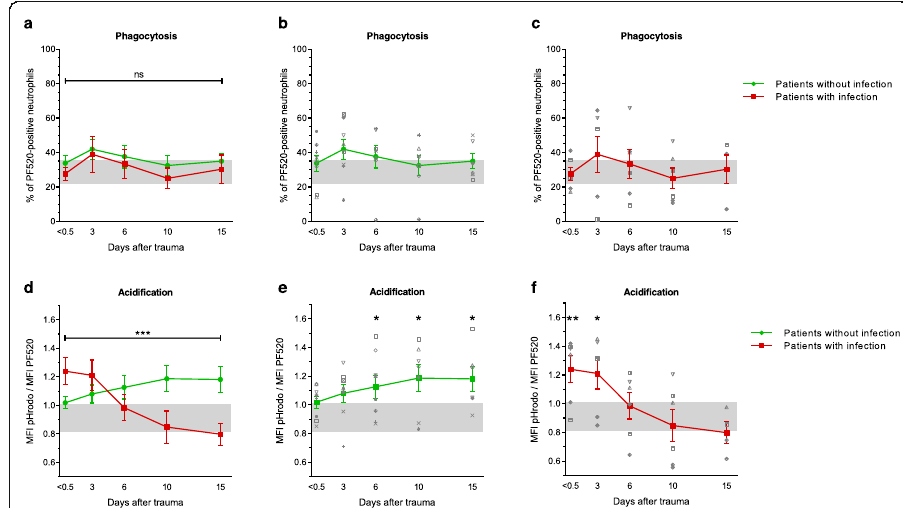
Fig. 2 Neutrophil functionality. Neutrophil phagocytosis ( a – c ) and neutrophil phagosomal acidification ( d – f ) in patients who developed an infection (red square) and patients who did not develop an infection (green circle) after 60 min of incubation with S. aureus bioparticles. Patients developed these infections between day 4 and day 9. Patients with infections were compared to patients without infections with generalized estimating equations (Fig. 2a, d). Additionally, patients were compared to healthy control values using a Mann-Whitney U test (Fig. 2b, c and Fig. 2e, f). Data are presented as mean with the standard error of the